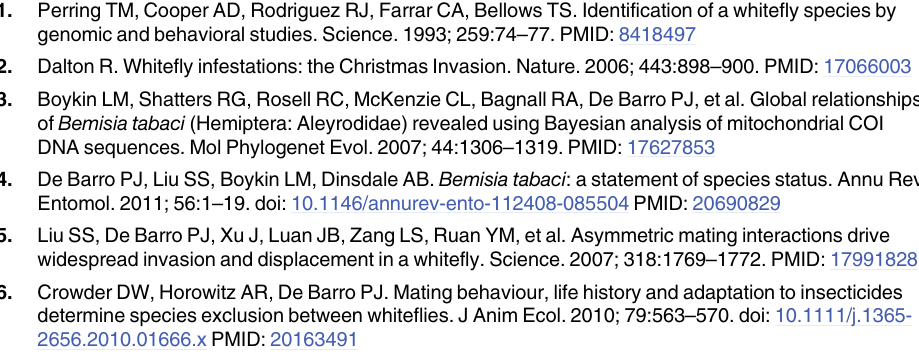
aleyrodidarum ” unitigs by blastn search against the genome sequence (accession number